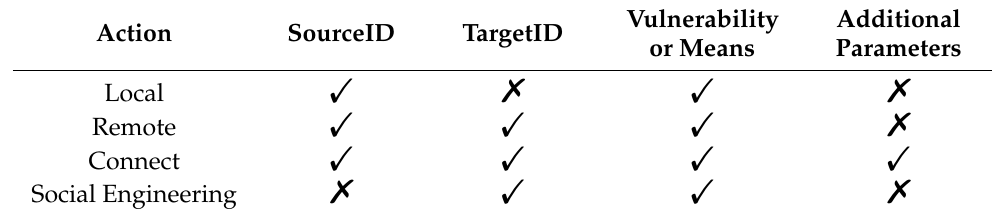
Table 1. The parameter of the attacker